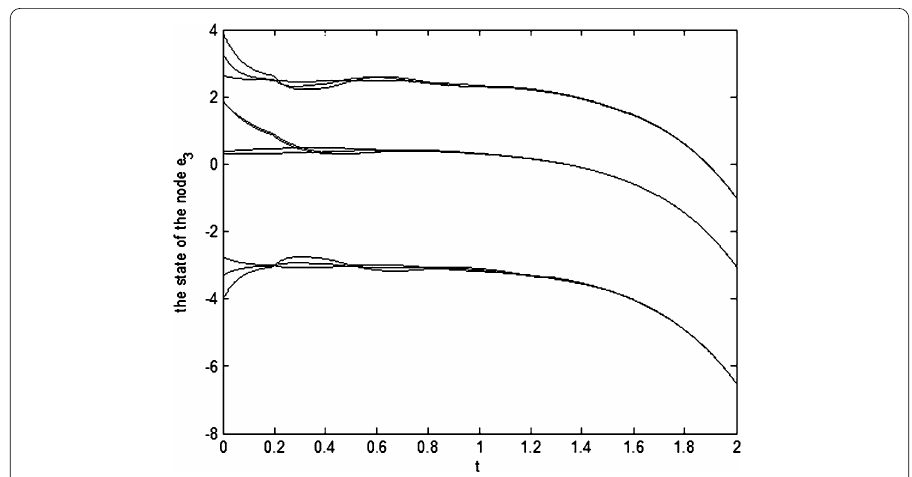
Figure 3 The state of the node e 3 without controller